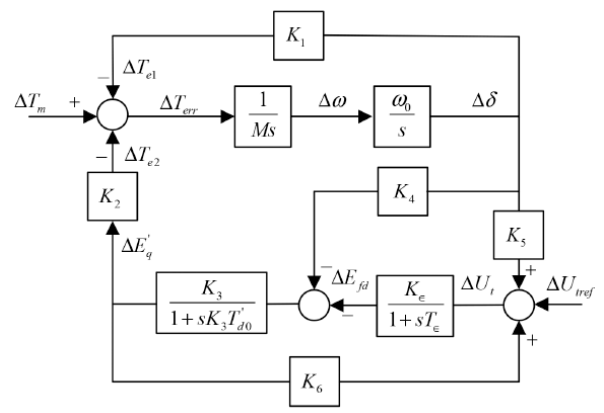
Figure 2. Small-signal model of the single synchronous generator infinite bus system [28].